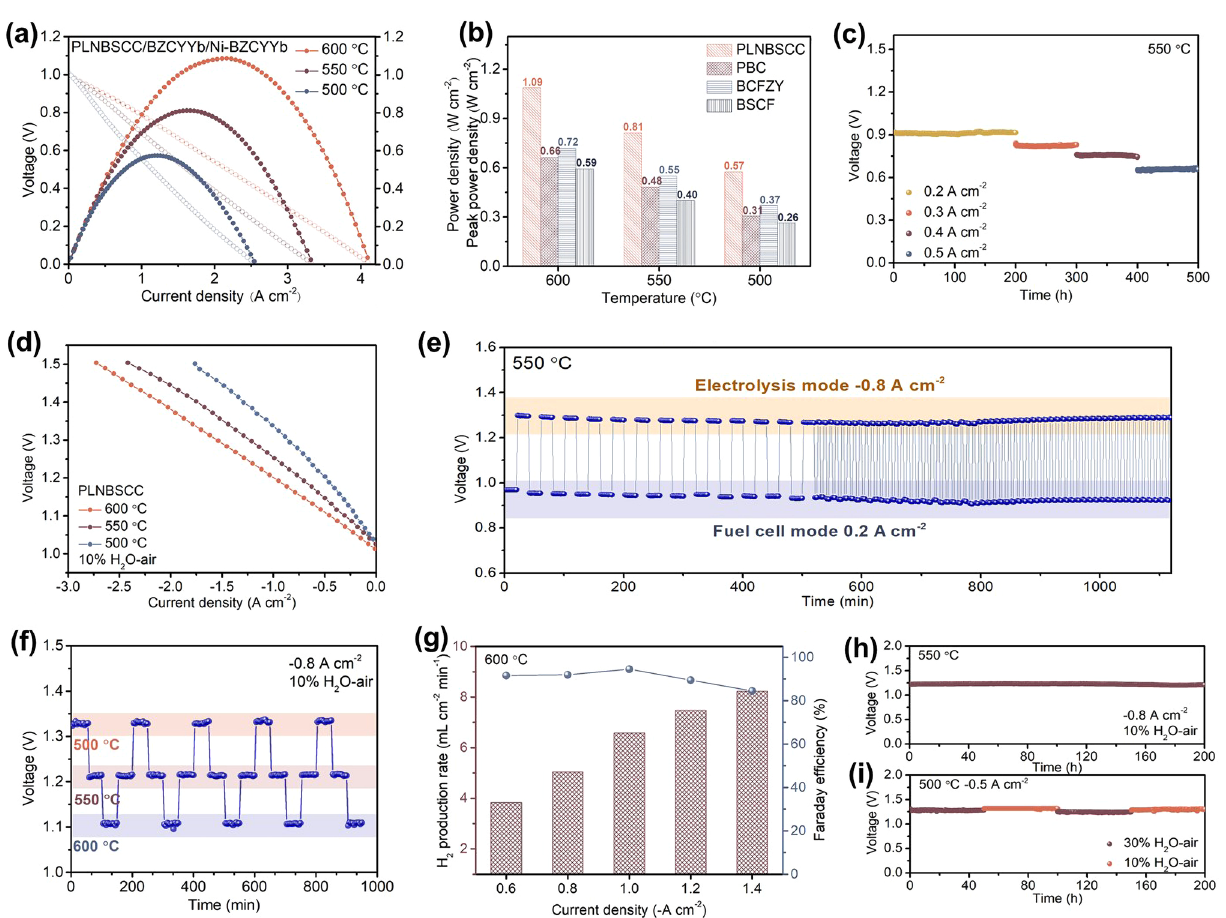
Fig. 4 a I – V and power density curves of single cell with high-entropy PLNBSCC as the air electrode at 500, 550 and 600 °C. b Peak power densities of PLNBSCC air electrode in fuel cell mode compared to PBC, BCFZY and BSCF air electrodes. c Stability of PLNBSCC cell in fuel cell mode at different current densities (0.2, 0.3, 0.4 and 0.5 A cm −2 ) and 550 °C. d Typical I – V curves of single cell with PLNBSCC electrode tested in electrolysis mode at 500–600 °C. e The voltages were observed in reversible operation of R-PCECs at 550 °C. f Thermal cycling dura- bility test in electrolysis mode at 500–600 °C. g Hydrogen production rate and FE as function of current densities at PLNBSCC electrode in electrolysis mode with argon in the fuel electrode and 30% H 2 O–air in the air electrode at 600 °C. h Stability test of single cell in electrolysis mode at galvanostatic current density − 0.8 A cm −2 and 550 °C. i Electrolysis cell durability test under different water pressure conditions (10% and 30% H 2 O–air) at 500